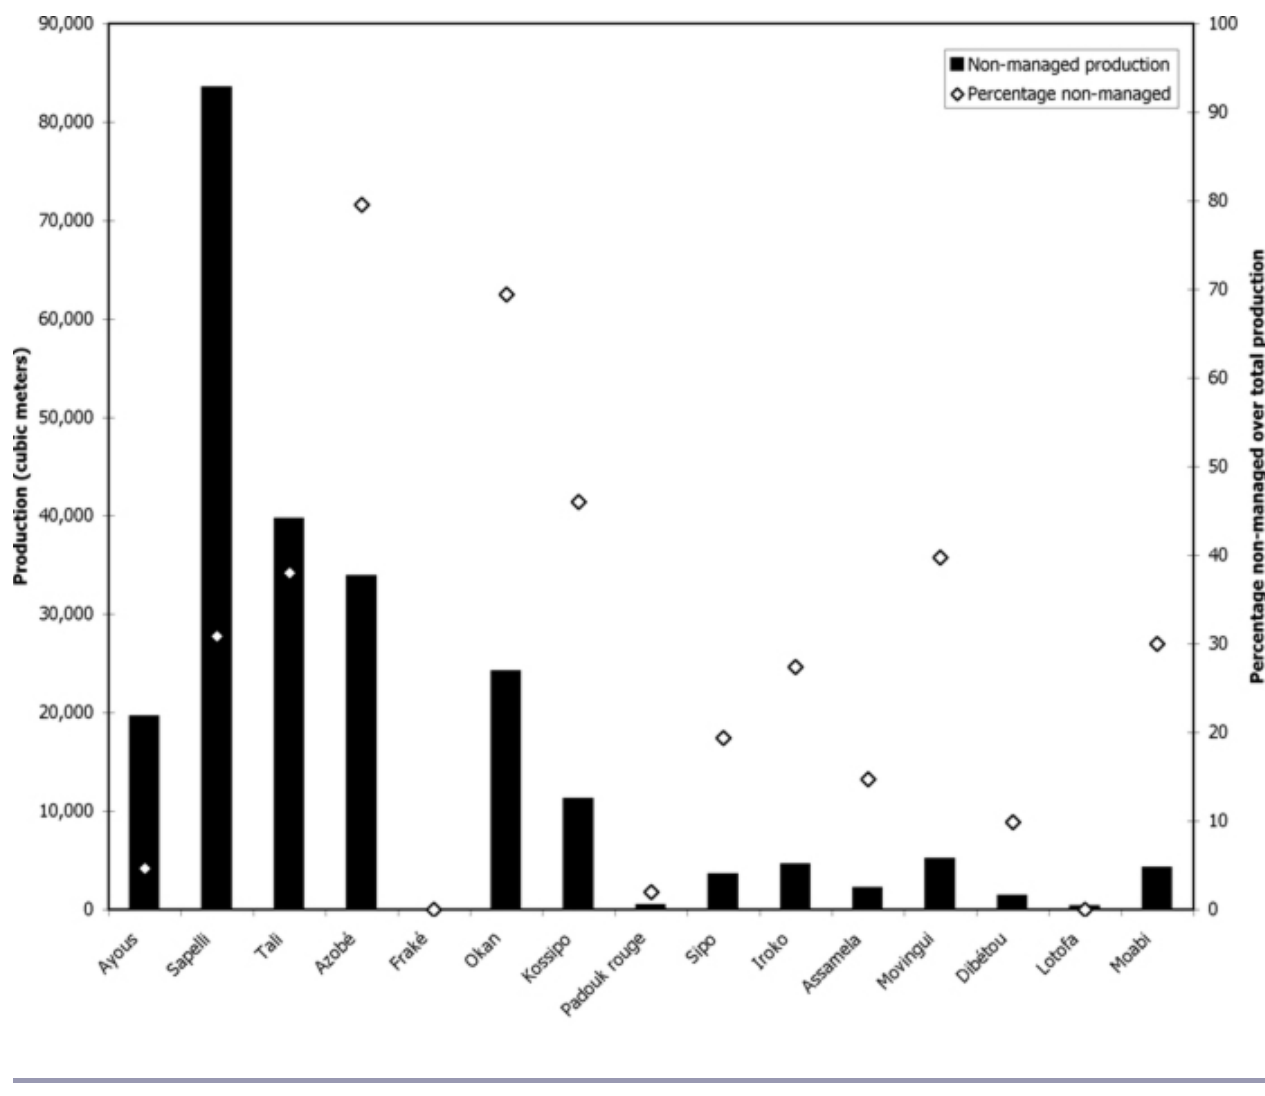
Fig. 2. Non-managed production in concessions with approved management plans, 2006 (15 most- harvested species) and percentage over total production of each